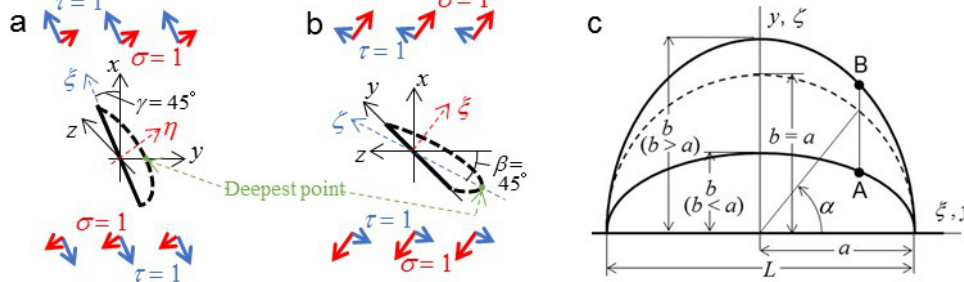
Figure 9: Inclined semi-elliptical surface-cracks in a semi-infinite body subjected to tension load in the x -direction at infinity: (a and b) a model for crack on the zx - and xy -planes; (c) the definition of  , and actual position for the zx - and xy -plane crack fronts. at  = 1° instead of  = 0°, because in 3-dimensional surface cracks, the point where the crack front intersects a free surface is known as a corner point. The stress singularity at this point is different from that of an ordinary crack [30]. Generally, it has been difficult to obtain smooth distributions of SIFs along the crack front